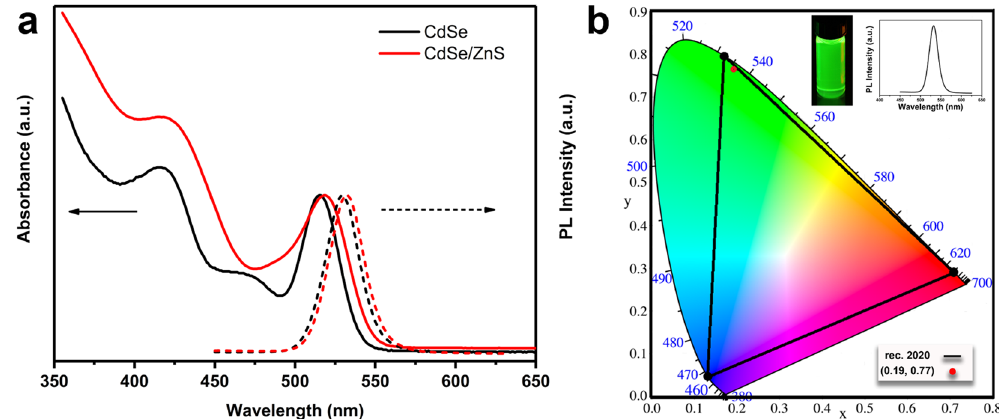
Figure 4. ( a ) PL spectra and absorption spectra of green-emitting CdSe cores and green-emitting CdSe/ZnS(7) TSQDs; ( b ) The corresponding CIE coordinates of green-emitting CdSe/ZnS(7) core/shell QDs synthesized by modified TOP-SILAR method using TOP extraction process. (Insets: as prepared QDs and the PL spectrum).